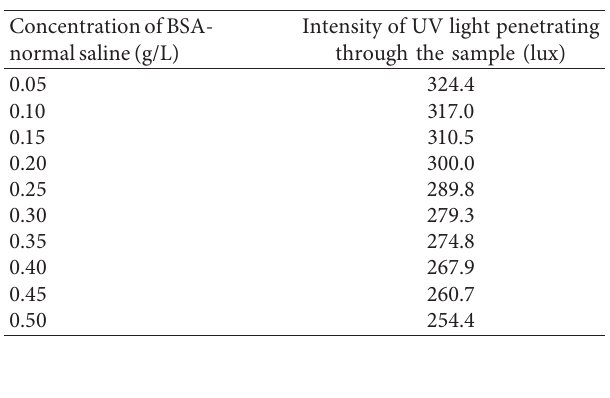
Table 1: Intensities of BSA-normal saline solutions measured by a smartphone.